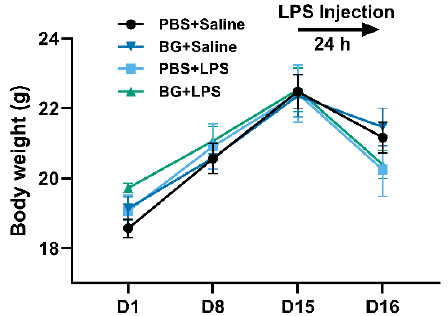
Figure 2. Changes of body weight during the experiment. PBS+Saline, mice administered PBS and injected with saline; BG+Saline mice administered 1.5 g/kg BW BG and injected with saline; PBS+LPS, mice administered PBS and injected with LPS; BG+LPS, mice administered 1.5 g/kg BW BG and injection with LPS. Data are presented as mean ± SEM, n = 6. An unpaired t -test was used for statistical analysis between two groups.